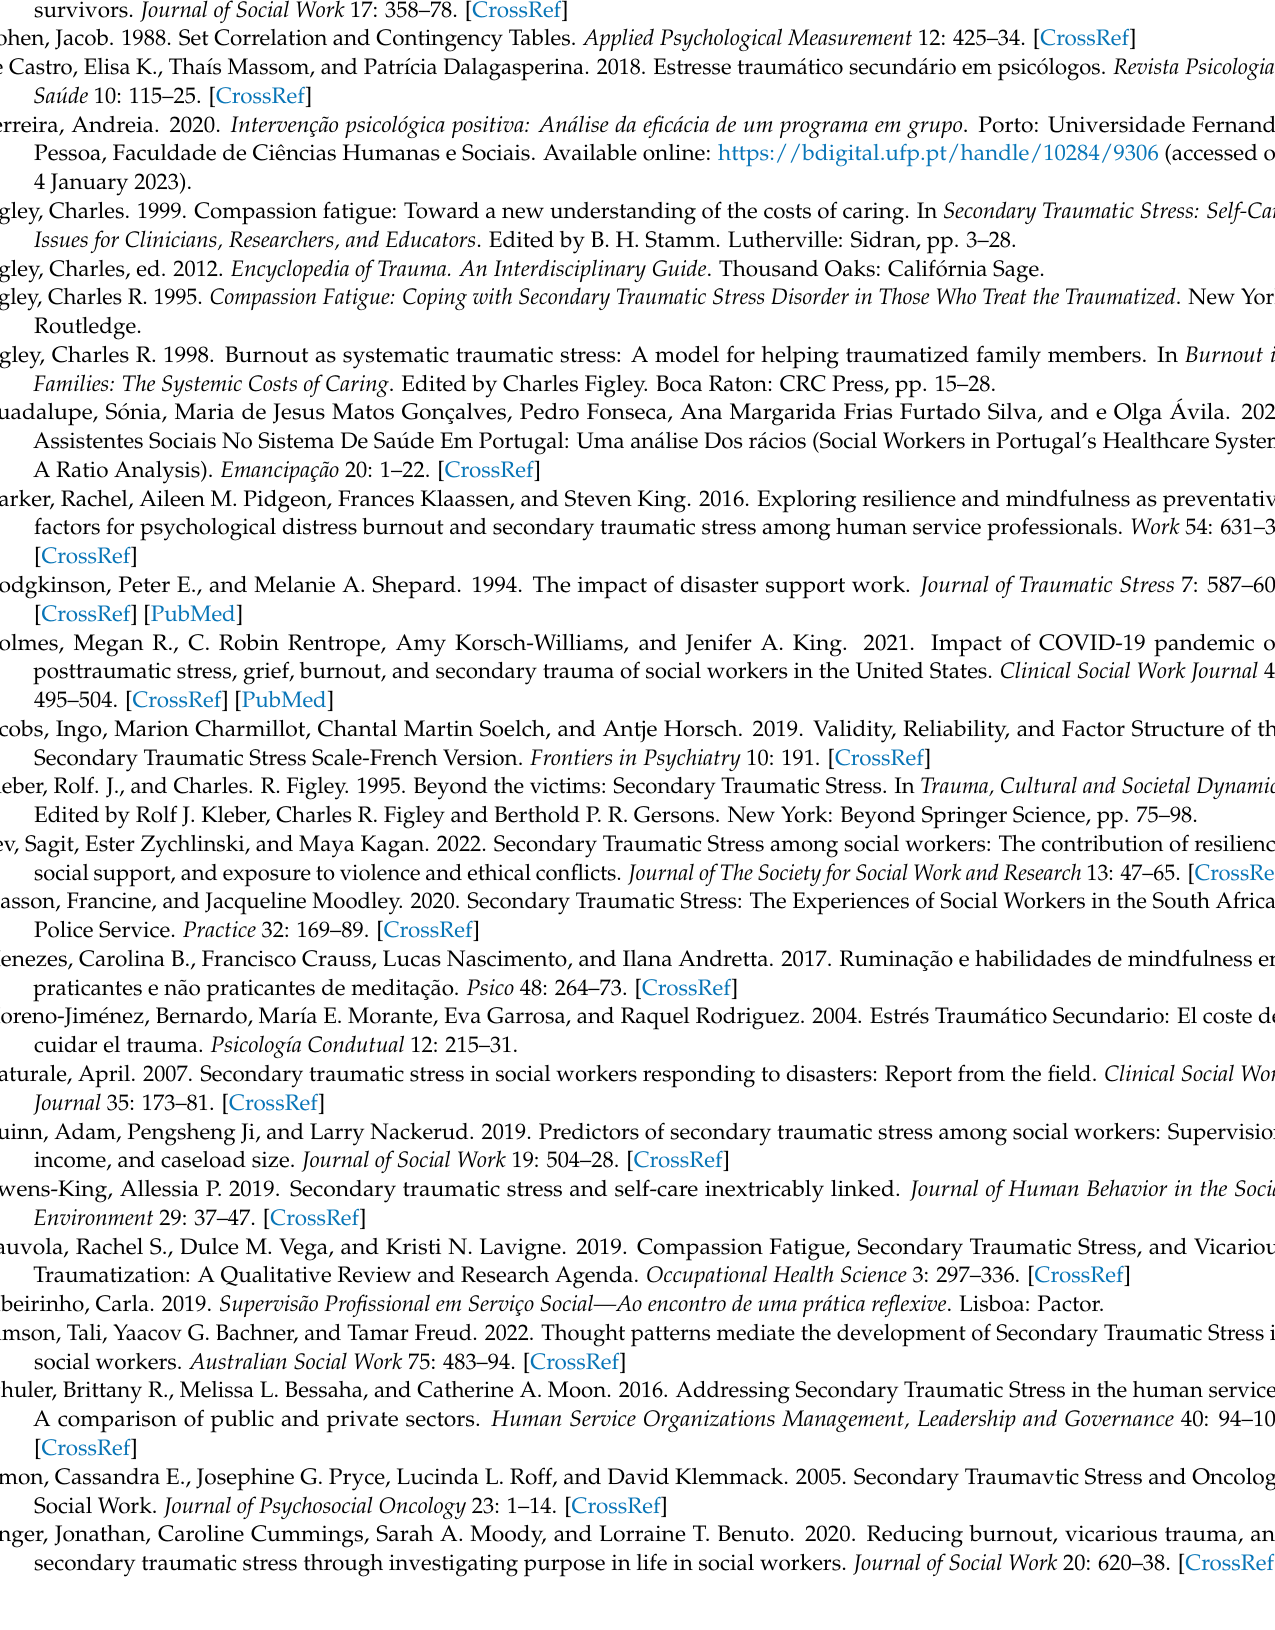
Figley, Charles. 1999. Compassion fatigue: Toward a new understanding of the costs of caring. In Secondary Traumatic Stress: Self-Care Issues for Clinicians, Researchers, and Educators . Edited by B. H. Stamm. Lutherville: Sidran, pp. 3–28. Figley, Charles, ed. 2012. Encyclopedia of Trauma. An Interdisciplinary Guide . Thousand Oaks: Calif ó rnia Sage. Figley, Charles R. 1995. Compassion Fatigue: Coping with Secondary Traumatic Stress Disorder in Those Who Treat the Traumatized . New York: Routledge. Figley, Charles R. 1998. Burnout as systematic traumatic stress: A model for helping traumatized family members. In Burnout in Families: The Systemic Costs of Caring . Edited by Charles Figley. Boca Raton: CRC Press, pp.